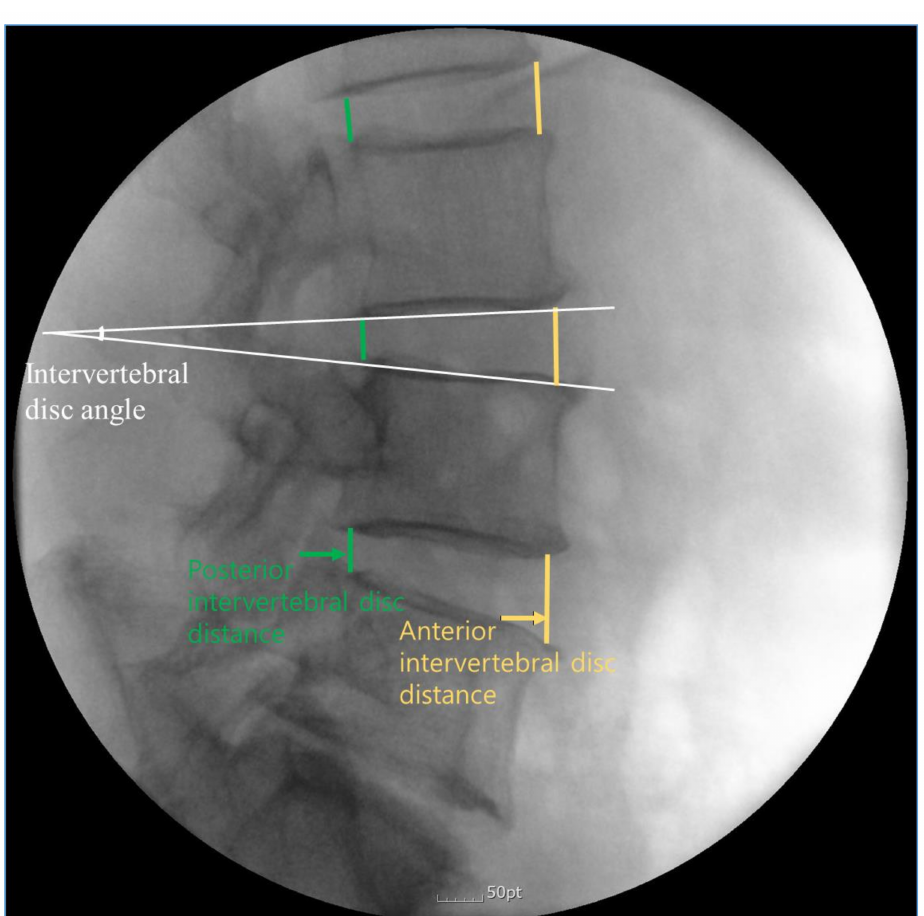
Figure 2. Illustration showing the measurement of intervertebral disc angle at L3/4 level, and intervertebral disc distance of anterior and posterior side.